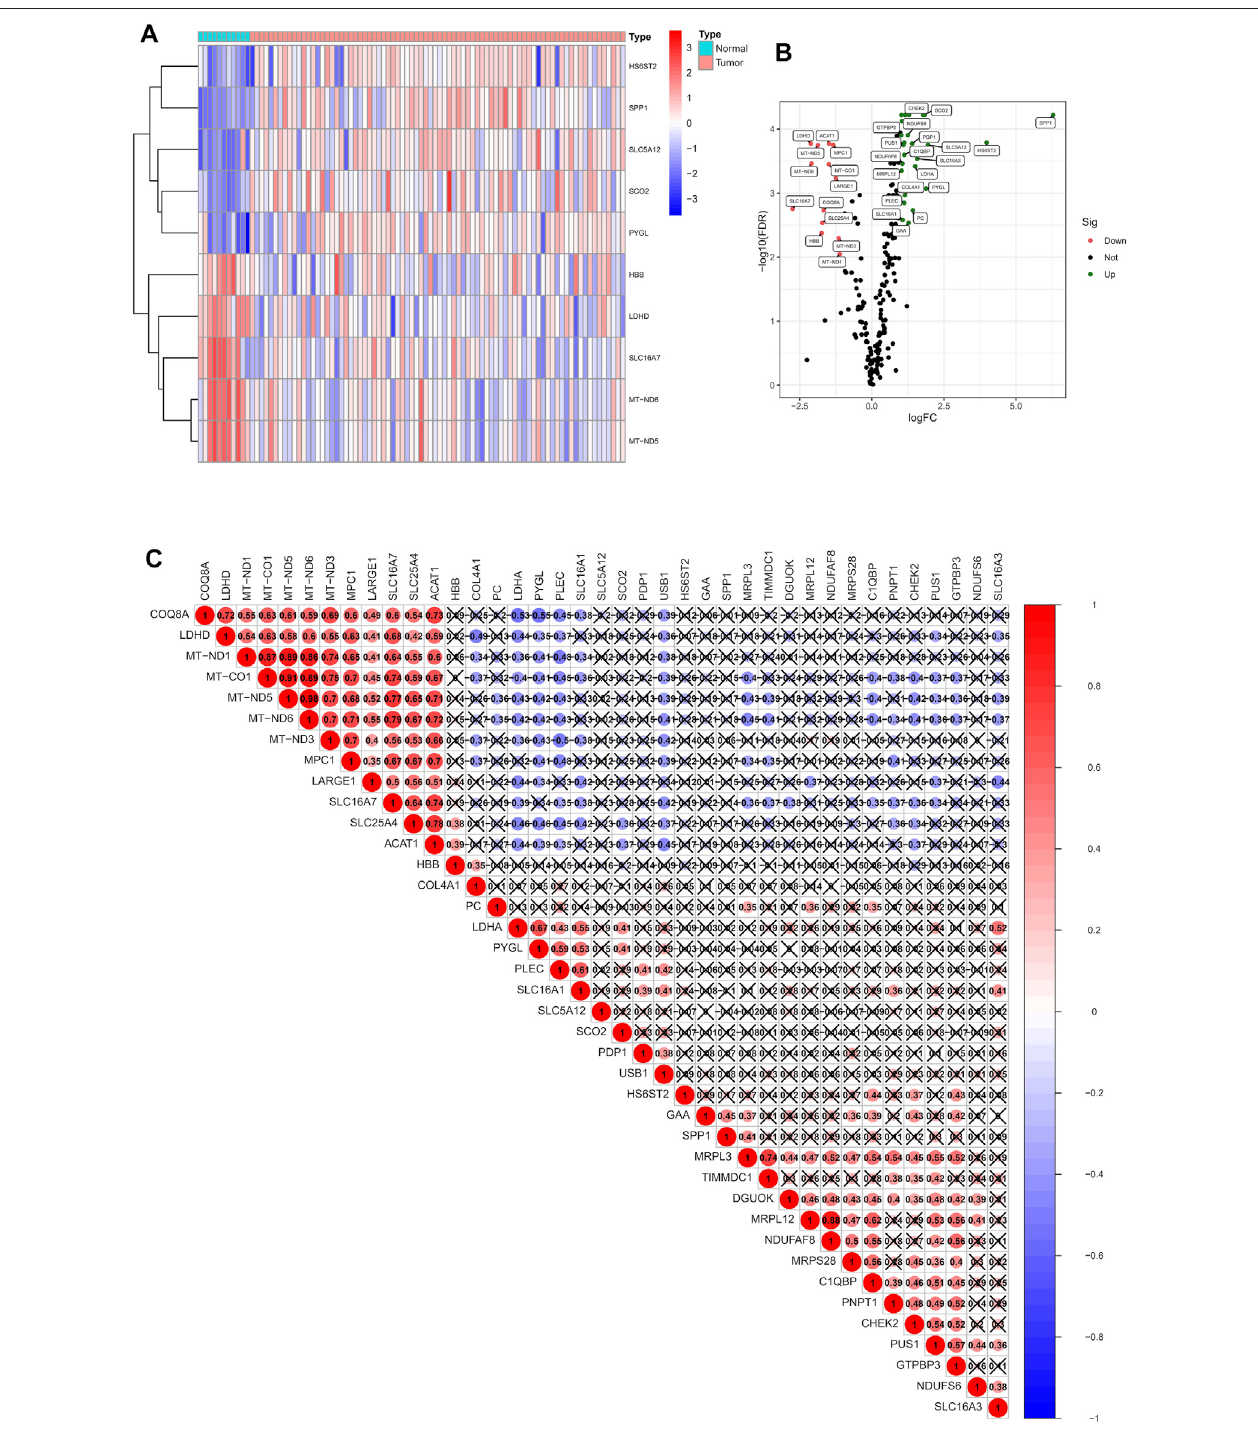
FIGURE 1 | Identi fi cation of LRGs in ESCC patients. (A) Heatmap of the differentially expressed LRGs. (B) Volcano plot of differentially expressed LRGs. (C) The positive and negative correlation between LRGs in ESCC patients.